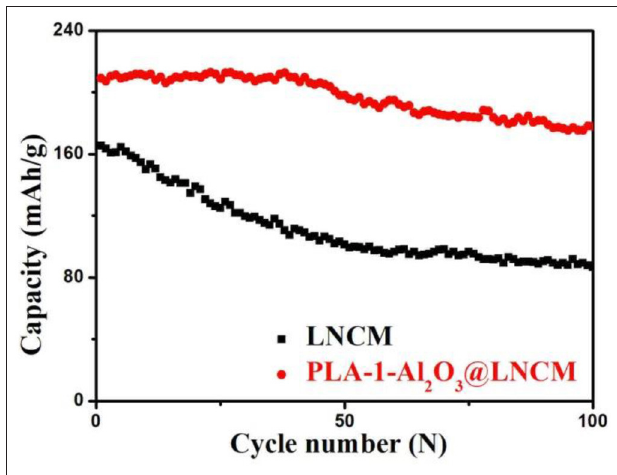
FIGURE 7 | Cyclic performances at 0.2 ◦ C of LNCM and PLA-1-Al 2 O 3 @LNCM at 55 ◦